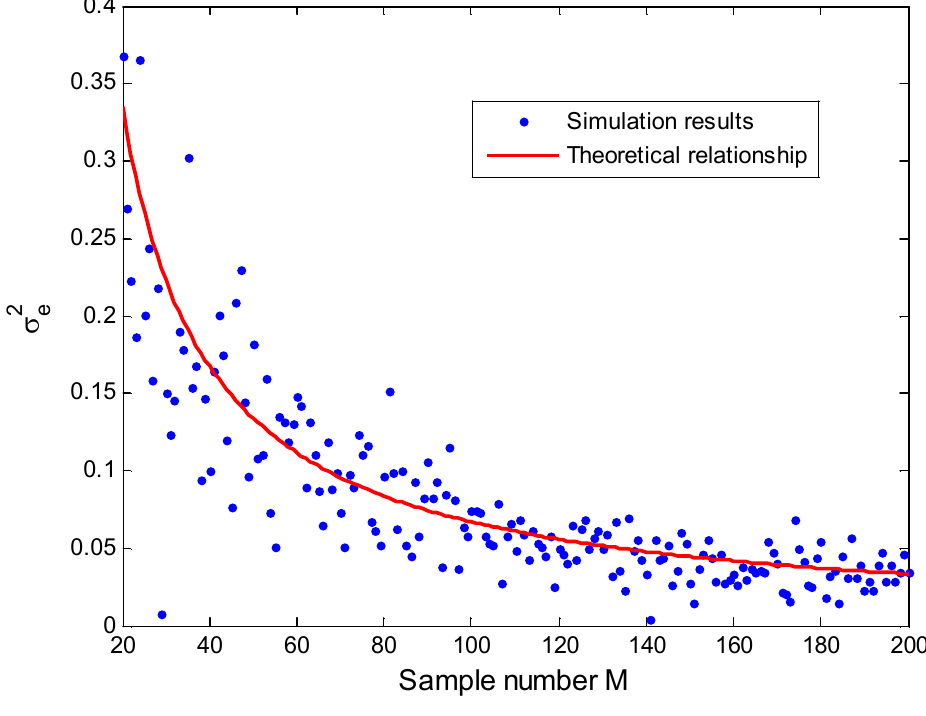
Figure 9. Relationship between σ 2 e and M for d k =